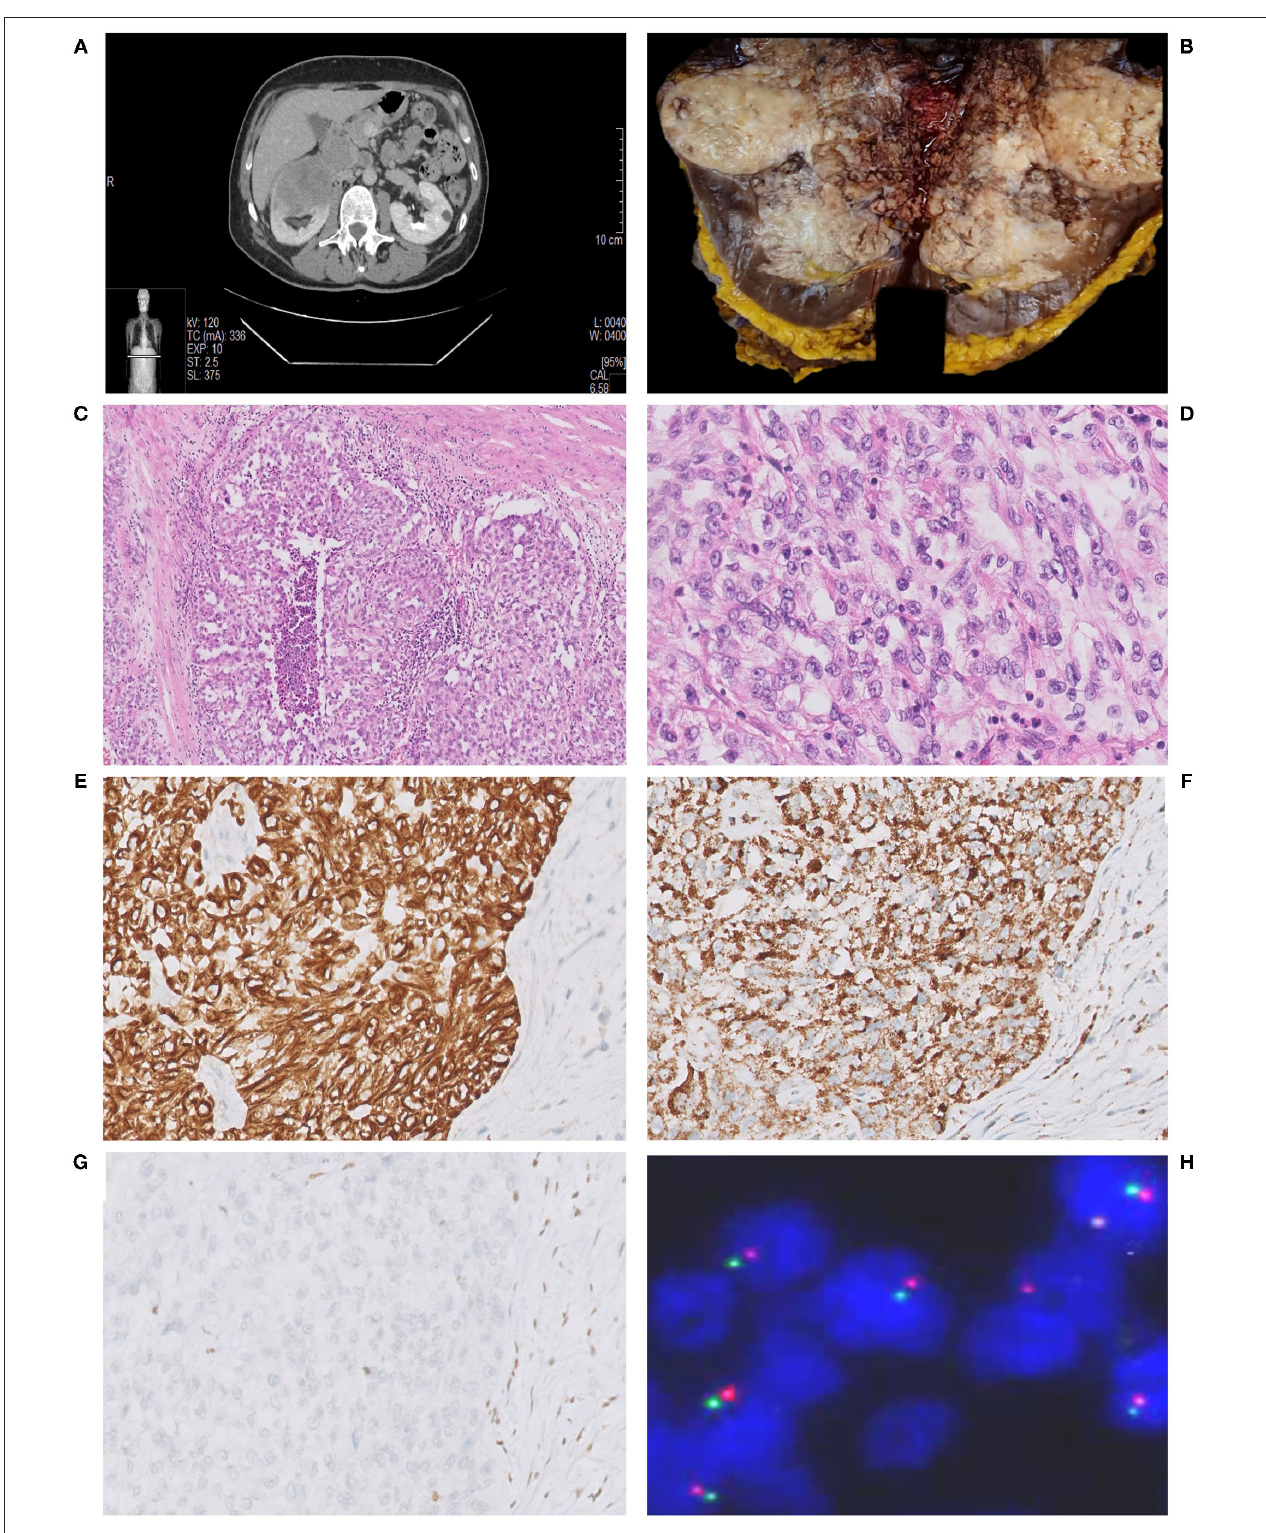
FIGURE 1 | Abdominal CT scan showing a bulky renal mass in the upper pole of the right kidney (A) . Grossly, renal parenchyma was partially replaced by a whitish, solid, and necrotic mass (B) . Histological view showing a solid proliferation of eosinophilic, highly pleomorphic, epithelioid cells, with nested growth pattern and focal pseudo-glandular differentiation, associated with desmoplastic stromal response. Multiple foci of necrosis were present (30% of tumor). Notably, many cells had a high